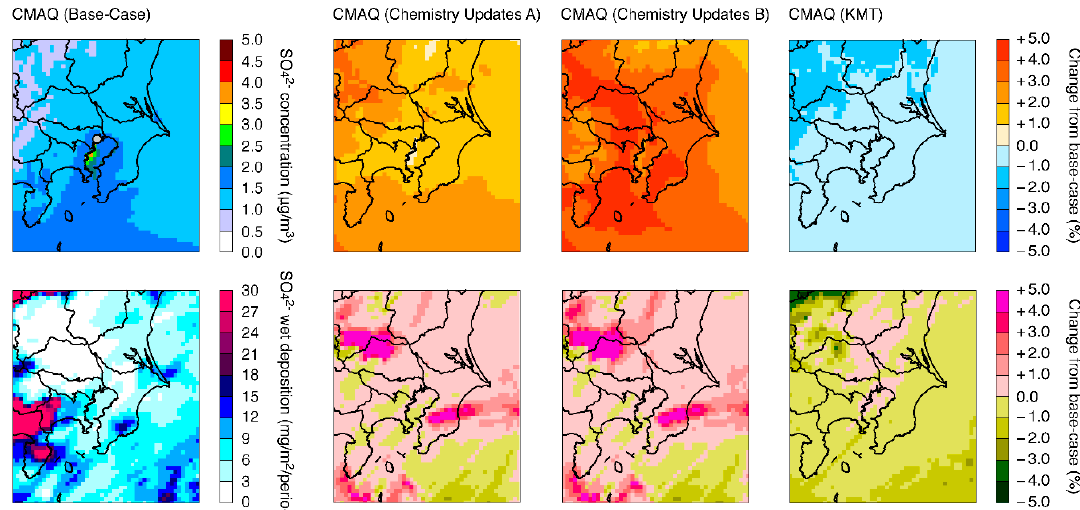
Figure 3. Spatial distribution of ( top ) ambient concentrations of SO 42– and ( bottom ) wet deposition simulated by ( left ) CMAQ base-case simulation and ( right ) changes by chemistry updates A, B, and KMT relative to the base-case averaged over the period 15–25 December 2016 over domain 4. The observation site at Tokyo is indicated by the gray circle.